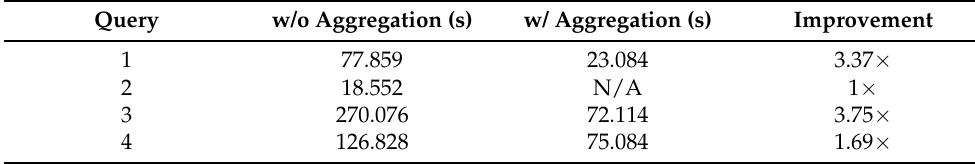
Table 2. Query times with and without aggregation using